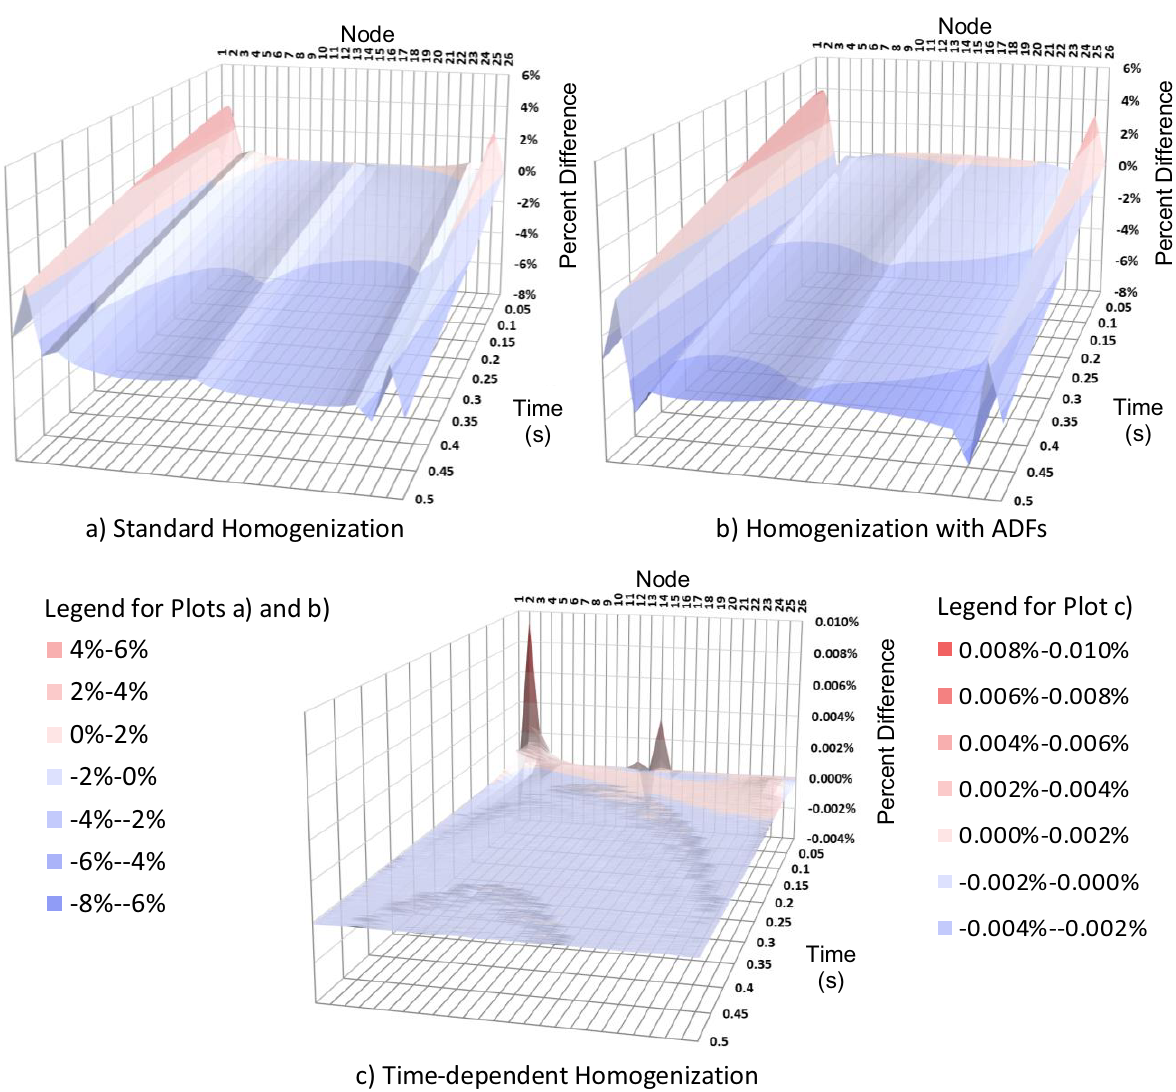
Figure 11. Percent Differences between the three Homogenization Techniques and the Node- averaged Reference Solution for the Thermal